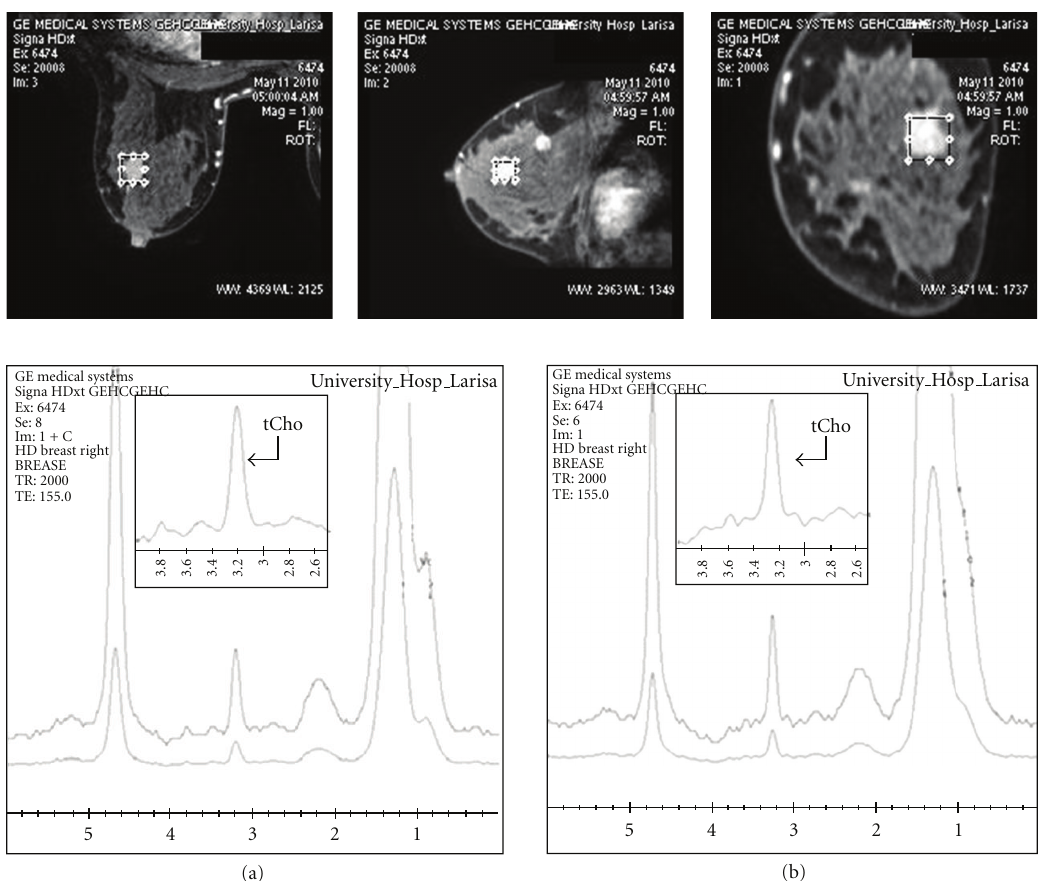
Figure 2: Breast MR spectra of a 49-year old patient, before (a) and 8min after (b) contrast injection using a voxel of 20 ∗ 20 ∗ 20 cm 3 . The relative tCho peak intensity increase and line-width narrowing in the postcontrast spectra is clearly visible after better readjustment of the voxel on the